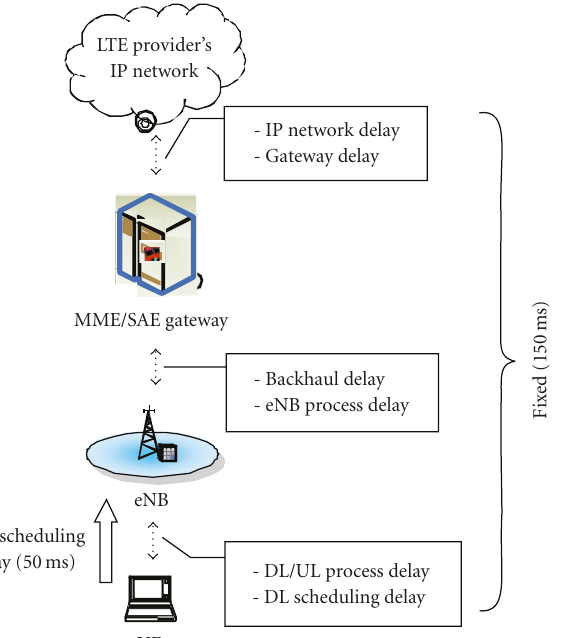
Figure 3: End-to-end delay components in E-UTRA.